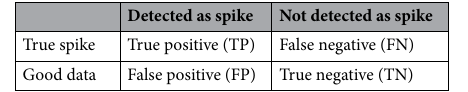
Table 1. Confusion